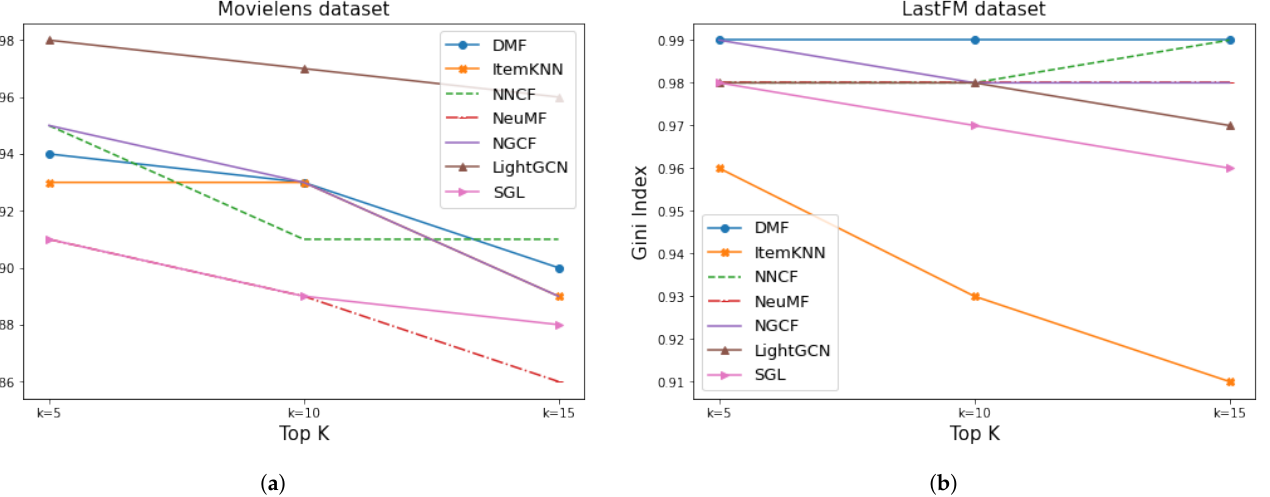
Figure 16. Results of Gini Index for Movielens and LastFM. ( a ) MovieLens Gini Index. ( b ) LastFM Gini